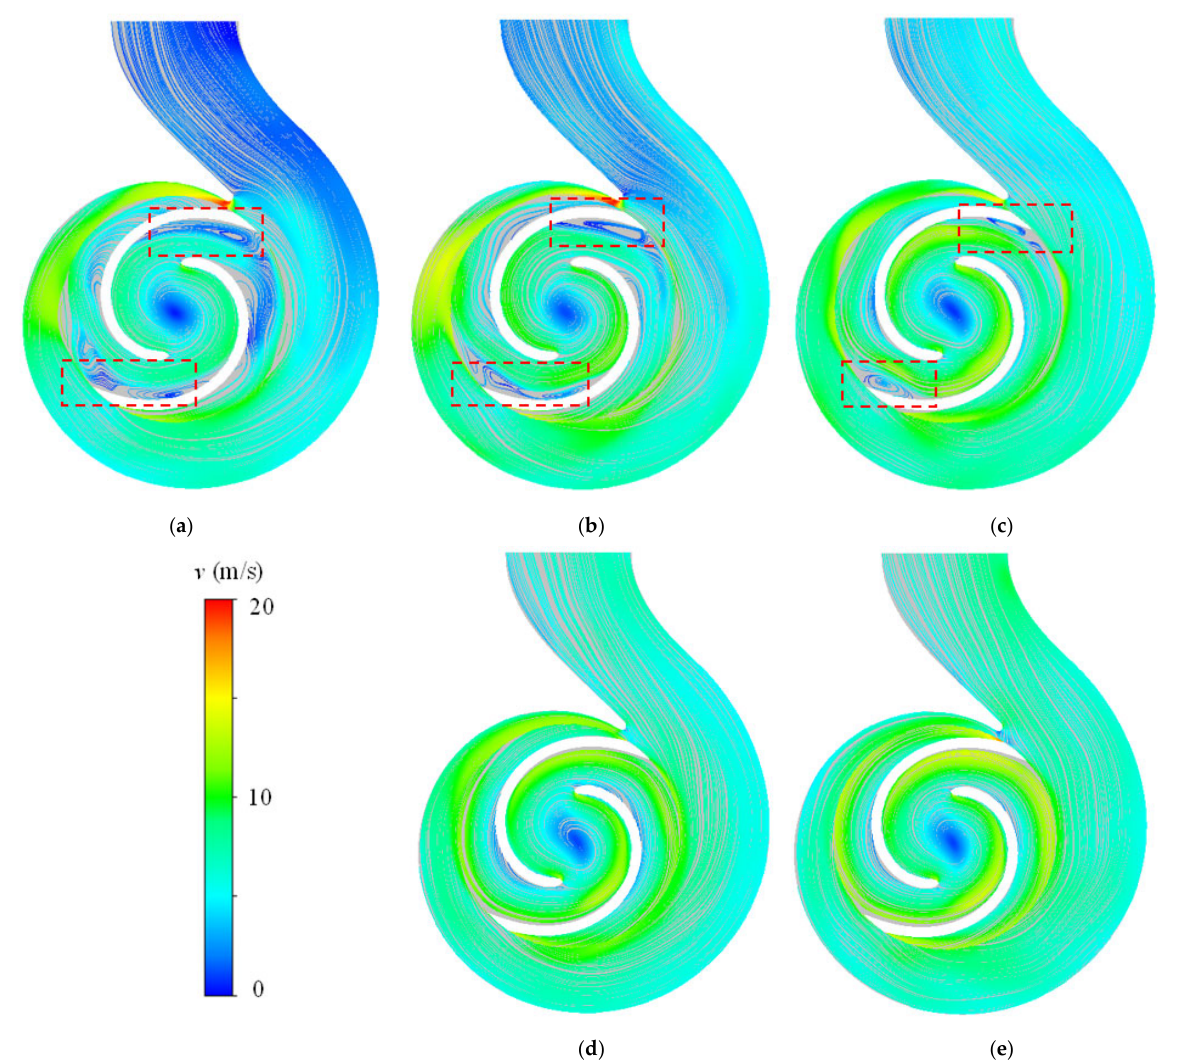
Figure 12. Flow velocity streamlines at mid ‐ span of pump under different flow rates: ( a ) 0.4 Q d ; ( b ) 0.6 Q d ; ( c ) 0.8 Q d ; ( d ) 1.0 Q d ; ( e ) 1.2 Q d .